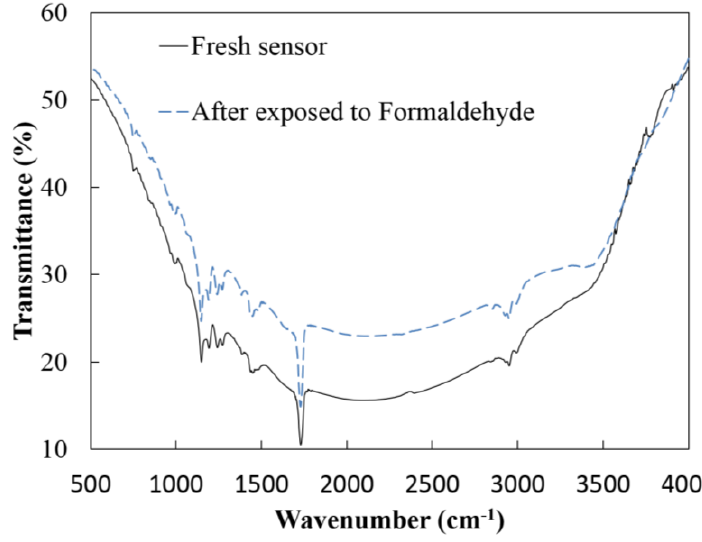
Figure 2. FTIR analysis for fresh RGO/PMMA based sensor (black line) and after sensor exposed to formaldehyde (dashed